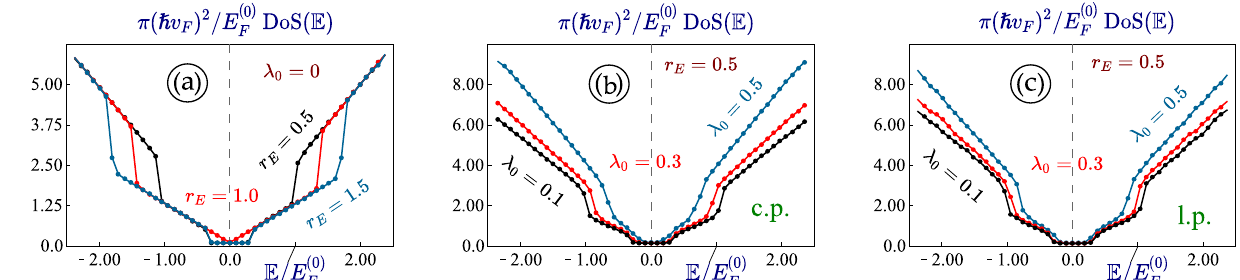
Figure 11. (Color online) Density of states Dos ( E ) of 1T ′ -MoS 2 under an optical-dressing field. Panel ( a ) demonstrates DoS ( E ) for non-irradiated 1T ′ -MoS 2 layer with different values of electrostatic-field strength: 0.5 (topological insulator phase), r 1.0 (spin- and valley-polarized semimetal) and r 1.0 (normal r E E = E = = 0.5 and a finite energy gap under both band insulator). Plots ( b ), ( c ) represent Dos ( E ) of 1T ′ -MoS 2 with r E = circularly- and linearly-polarized dressing field, separately. For both ( b ) and ( c ), each curve corresponds to a different value of light-electron coupling constant (cid:31) 0 as